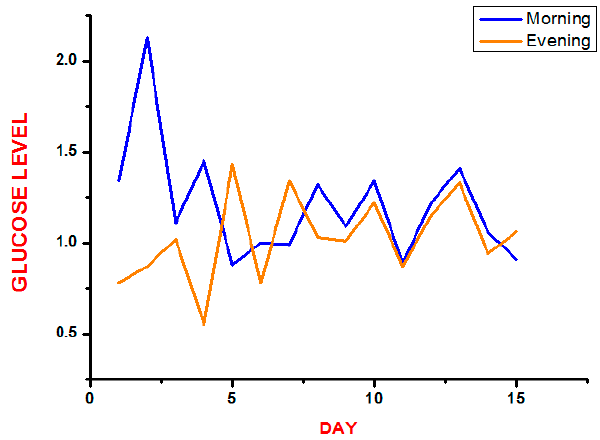
Figure 9. Measurement of the level of glucose in the blood.